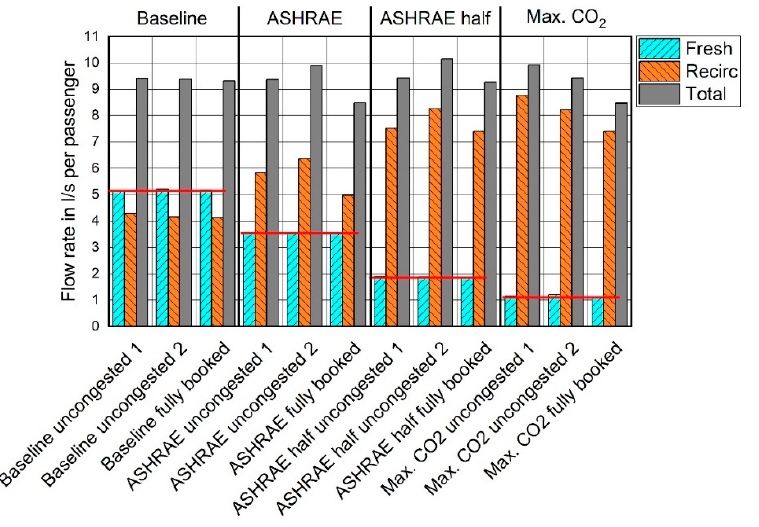
Figure 6. Passenger based airflow rates in the cabin.